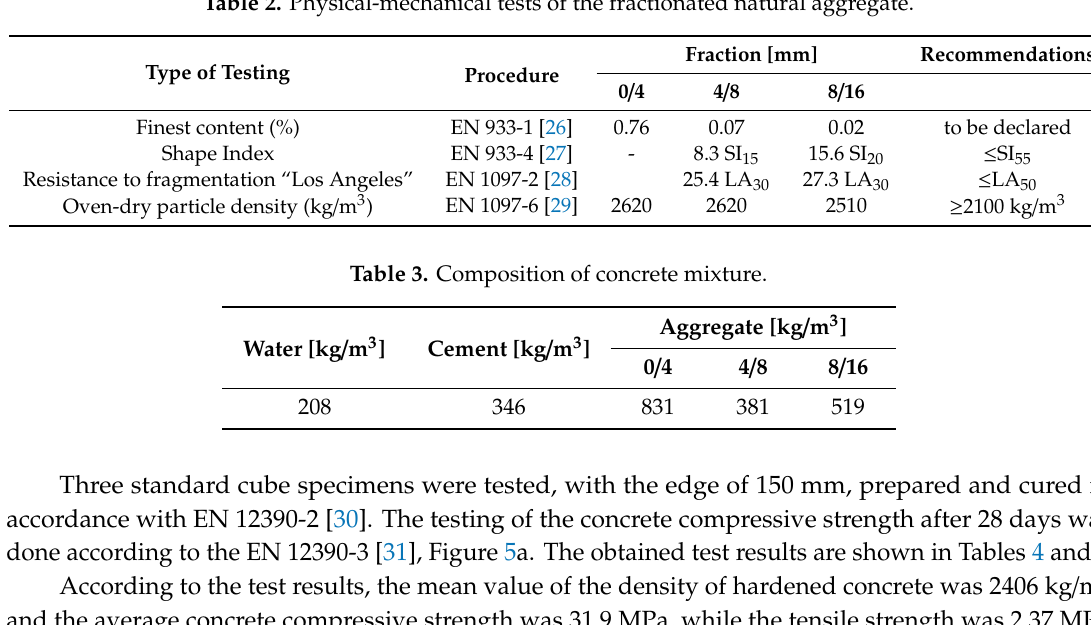
Table 2. Physical-mechanical tests of the fractionated natural aggregate.